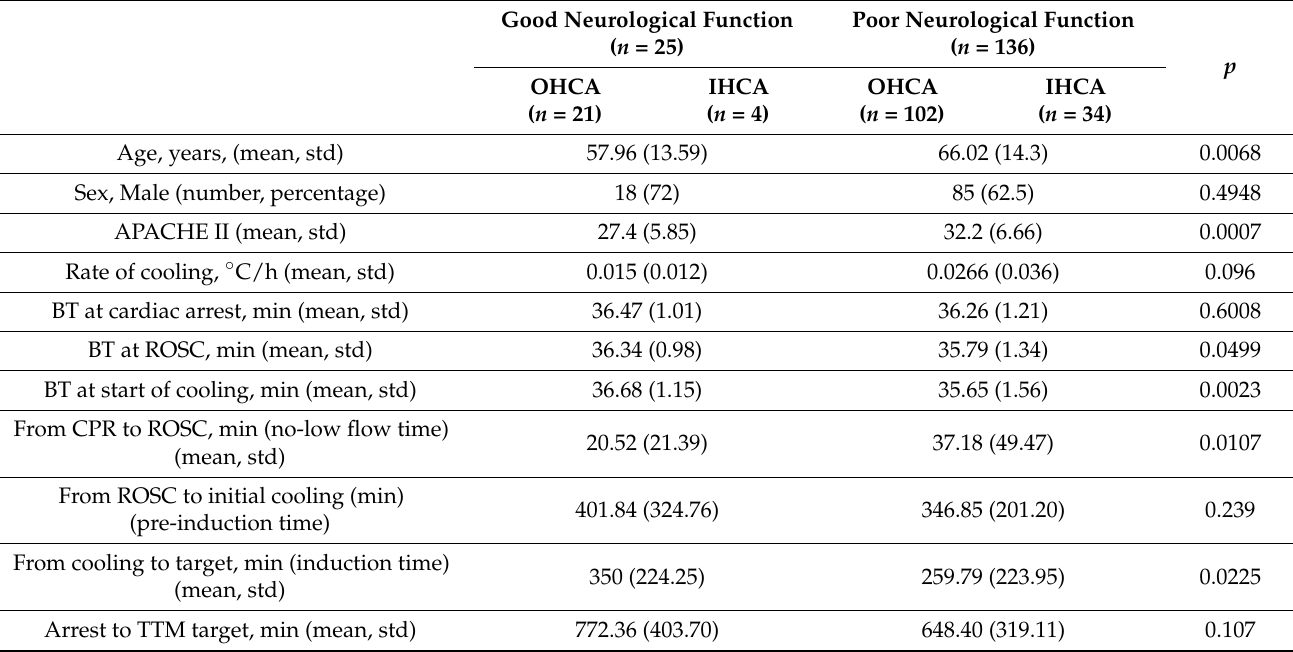
Table 2. Comparisons of the patients with IHCA/OHCA with good and poor neurological outcomes at day 28.